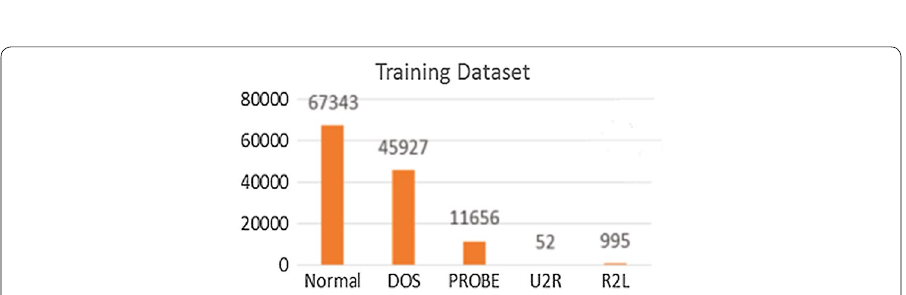
Fig. 7 Statistics about NSL-KDD training dataset [3]. Shows Statistics about NSL-KDD testing datasets. Statistics about number of samples for each type of